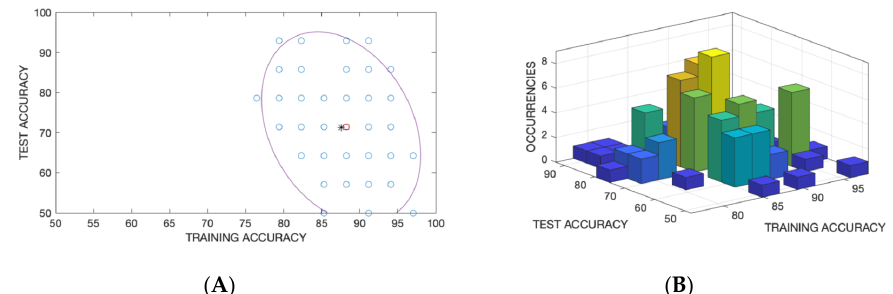
Figure 9. ( A ) Plot of accuracy of the Linear Discriminant Analysis (LDA) classifier for 100 random partitions of the data in training and test sets. ( B ) Frequency of occurrence of the multivariate variable made by the accuracy in training and test sets. The ellipse in Figure 9A shows the covariance matrix of the bi-variate normal distribution. The mean value, corresponding to the center of the covariance matrix, was chosen to represent the results. Table 1. Confusion matrix of the LDA model in training and test. Correct identifications are emphasized with bold font.